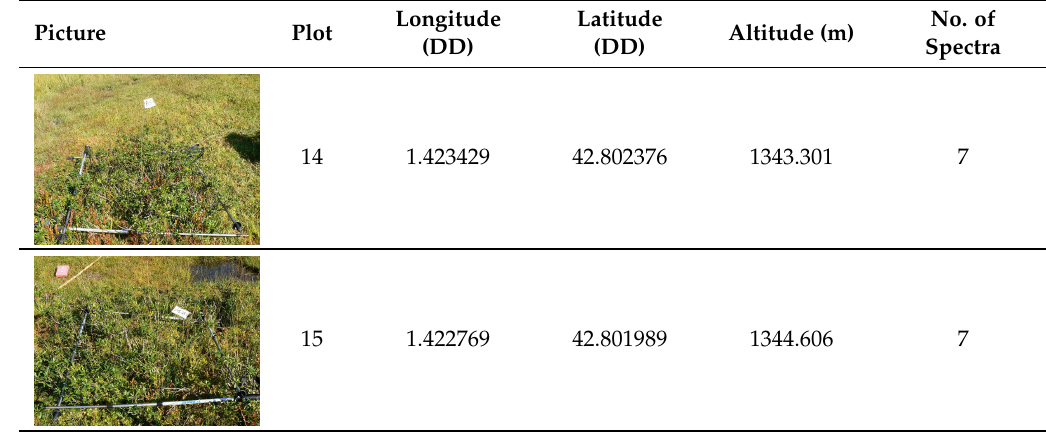
No. of Longitude Latitude Altitude (m) Spectra (DD) (DD)